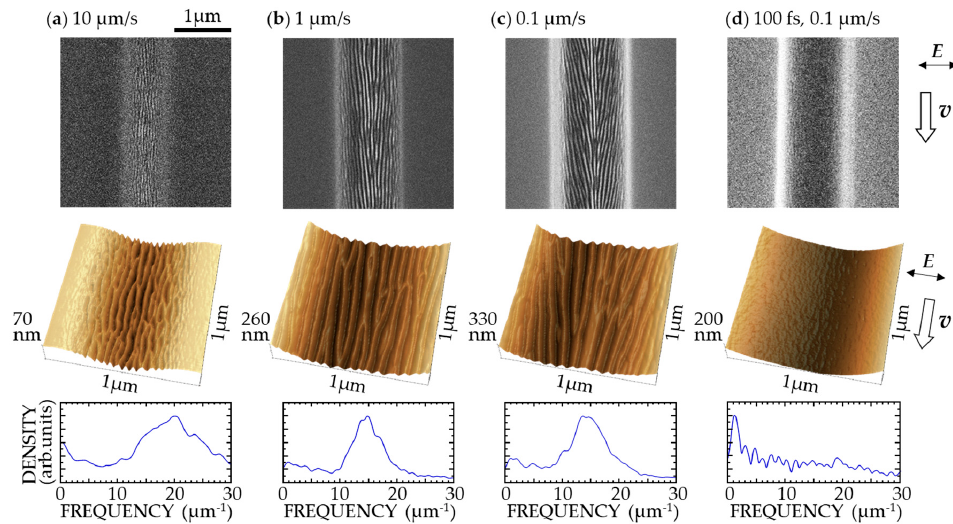
Figure 2. Scanning electron microscopy (SEM) images ( top ), scanning probe microscopy (SPM) images ( middle ), and spatial frequency spectra ( bottom ) of a diamond-like carbon (DLC) film surface irradiated with 7-fs pulses, with I = 1 TW/cm 2 at F = 6 mJ/cm 2 for ( a ) v = 10 μ m/s, ( b ) v = 1 μ m/s, and ( c ) v = 0.1 μ m/s, and ( d ) those irradiated with 100-fs pulses with I = 0.1 TW/cm 2 at F = 6 mJ/cm 2 for v =